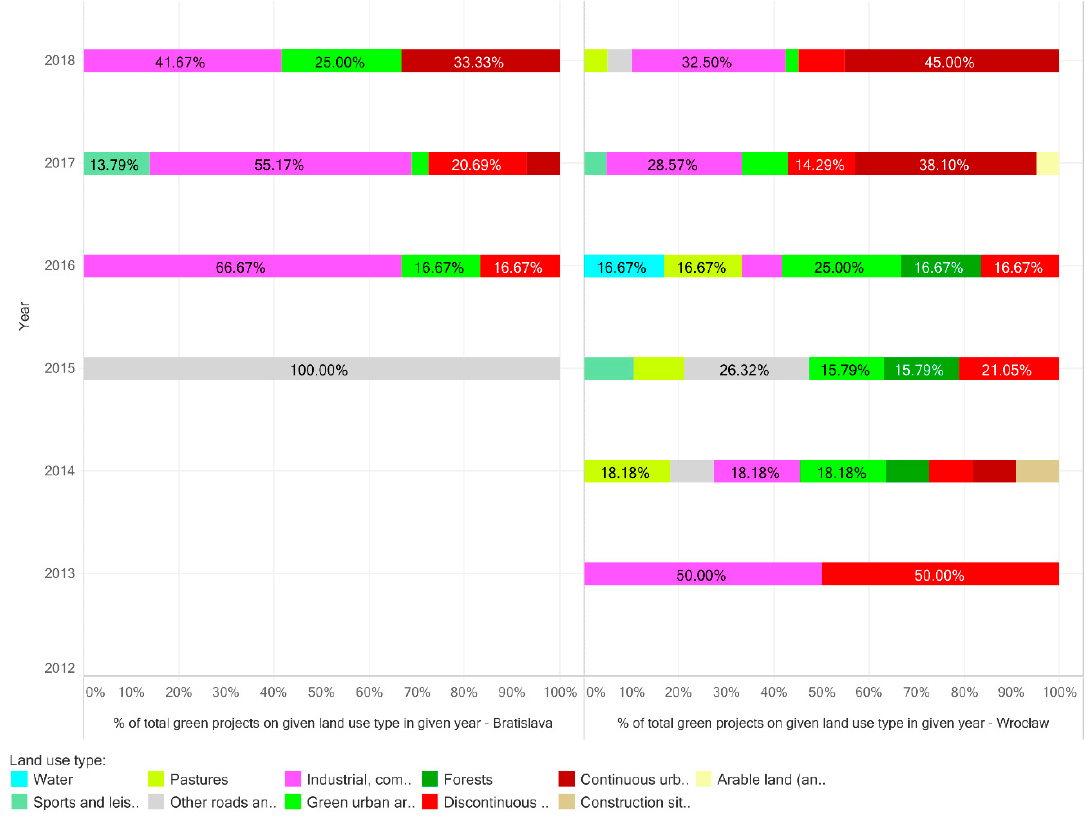
Figure 5. The comparison of projects realized in Bratislava and Wrocław according to year and land use type. Source: Own elaboration using Tableau software.